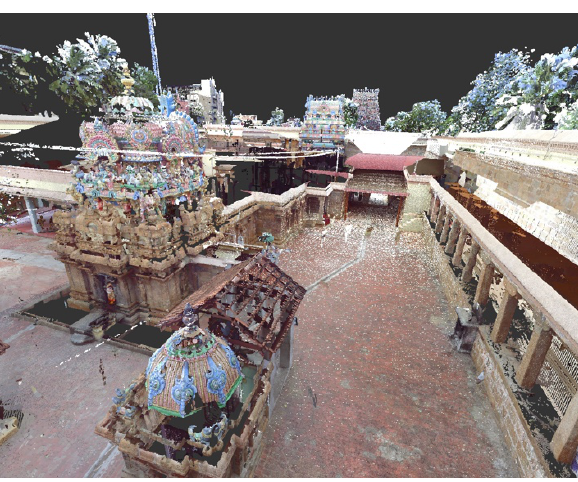
Figure 12. SFM Mesh of Yali on front façade of Pudu Mandapam from photographs taken 2018 5.3 Suggesting alteration